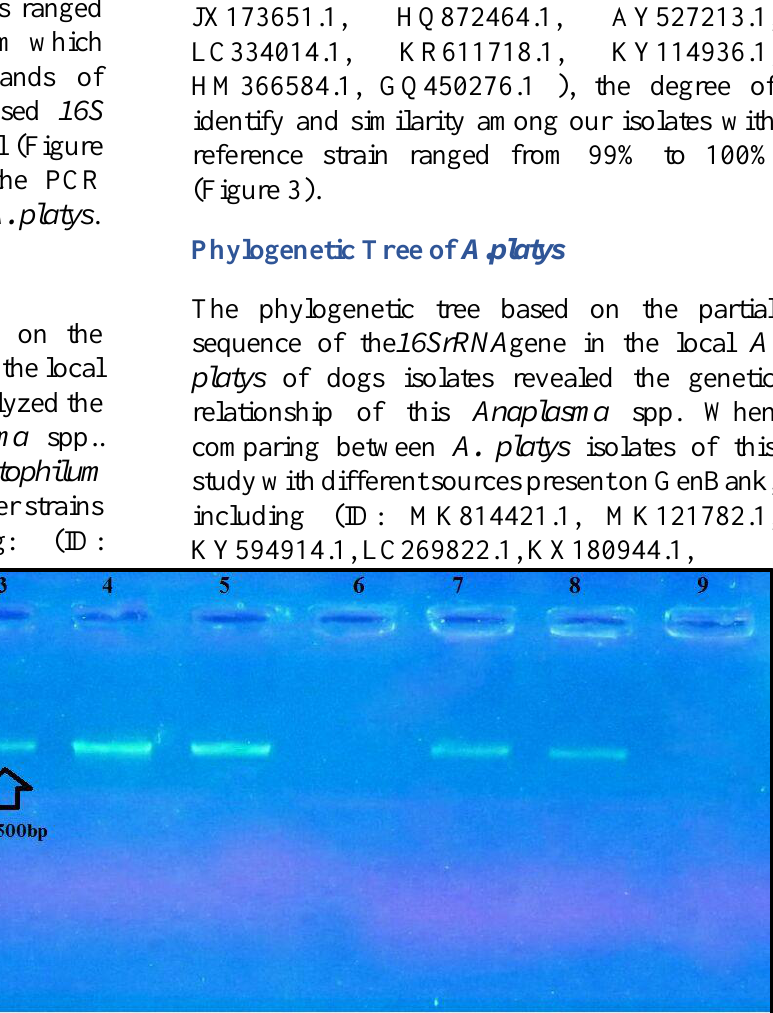
Figure 1. Agarose gel electrophoresis for 16S rRNA gene (1500bp) of A. phago cytophilum. Bands were fractionated by electrophoresis on a 1.5% agarose gel for 2 hrs at 5 volt/cm 2 ) and visualized under UV light after staining with red stain. Lane M: DNA ladder (100 bp)